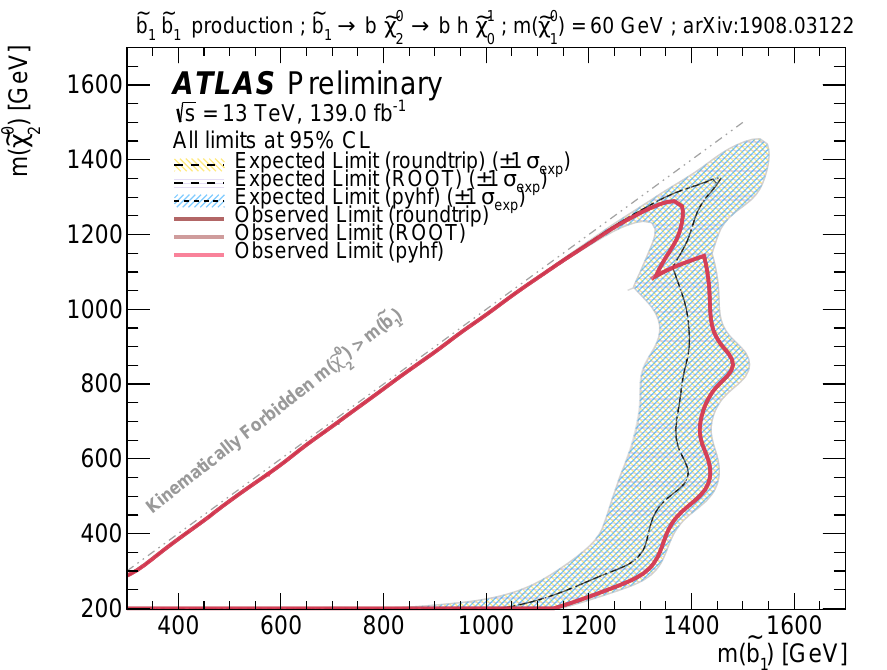
Figure 2: Exclusion contours at the 95% CL in the m (˜ b 1 , ˜ χ 0 ) phase space for the m (˜ χ 0 ) = 2 1 60 GeV signal scenario using the SR with the best-expected sensitivity. The shaded band shows the impact of the theory uncertainties on the SM background, and the experimental uncertainty on both the background and the signal. The contours labeled ROOT are calculated from the original workspaces of the analysis. From these original workspaces, xml2json was run and pyhf was used to produce the contours labeled pyhf . Finally, json2xml was used to generate XML and ROOT files, from which ROOT workspaces can be built, to produce the contours labeled roundtrip . The overlaid expected and observed limits and the exclusion contours, produced by pyhf and ROOT , reproduce the contours of Figure 8(a) in Ref. [8] with excellent agreement. All curves are superimposed at the level of graphical precision